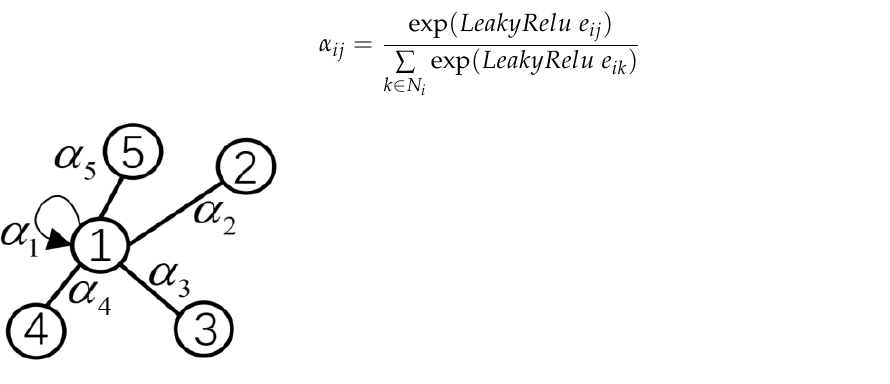
Figure 5. Schematic diagram of the attention mechanism.